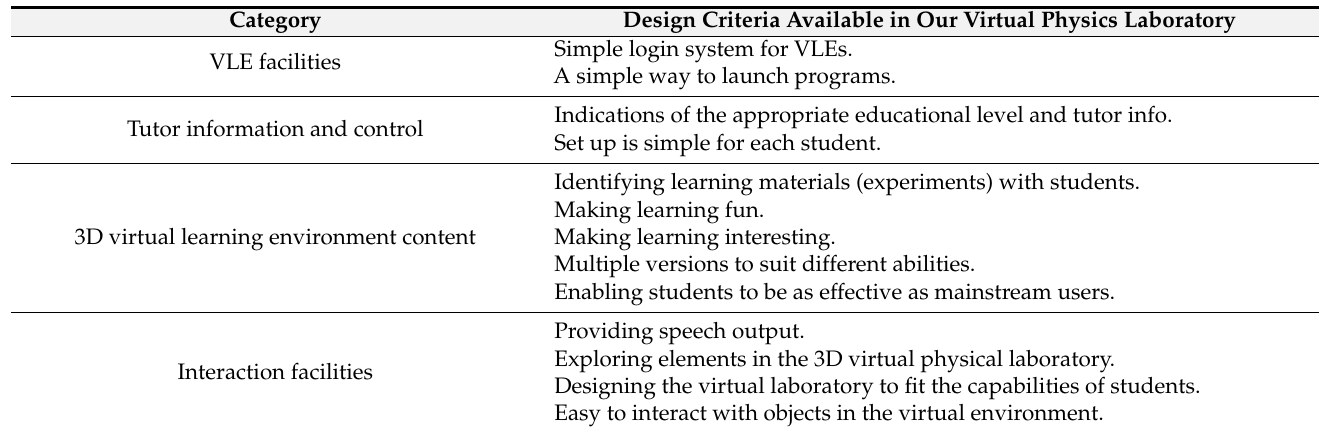
Table 1. Design criteria in 3D virtual physics laboratory.